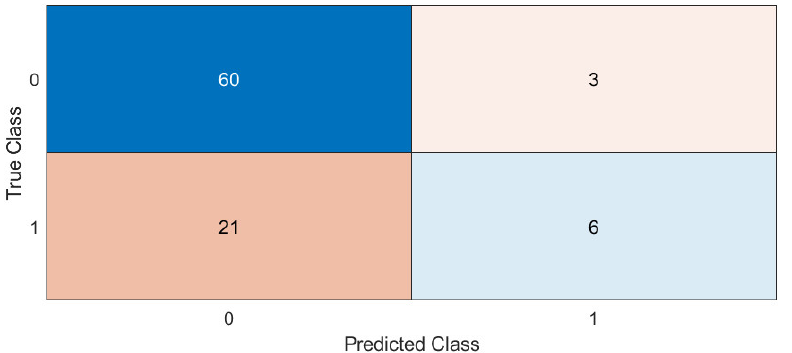
Figure 6. Example of the total confusion matrix.